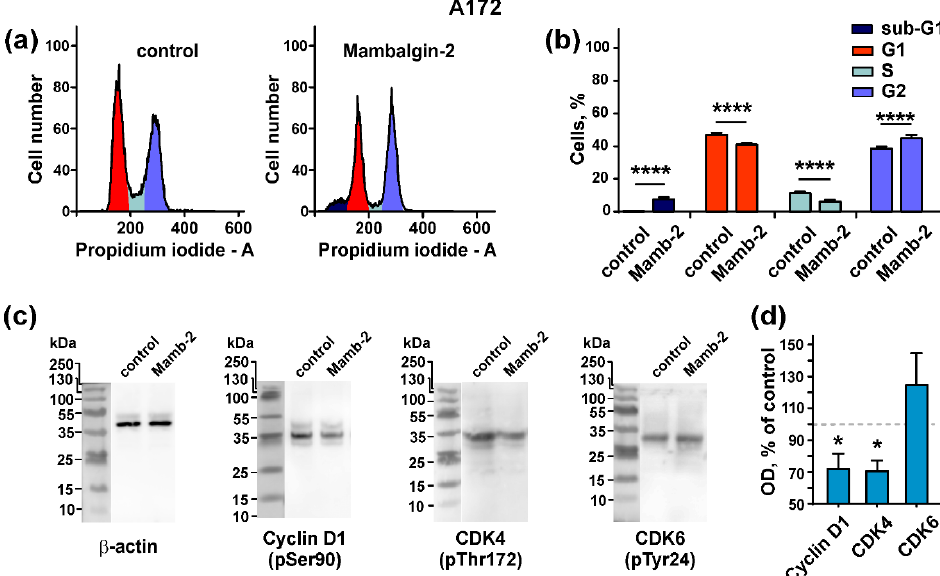
Figure 6. Mambalgin-2 influence on the cell cycle and activity of cell cycle regulators in A172 cells: ( a ) Representative nuclei population distributions of cells after 72-h incubation in absence (control) or presence of 1 µ M mambalgin-2; ( b ) % of cells in each cell cycle phase determined by ModFitLT Software. Data are presented as % of cells in each cell cycle phase ± SEM, n = 4; **** ( p < 0.0001) indicates the significant di ff erence from the control by two-tailed t -test; ( c ) Representative Western blots, showing the mambalgin-2 influence on phosphorylation of Cyclin D1 (pSer90), CDK4 (pThr172), and CDK6 (pTyr24); ( d ) The optical density (OD) of blot bands for comparison of the Cyclin D1 (pSer90), CDK4 (pThr172), CDK6 (pTyr24) expression upon 72-h incubation of the cells in absence (control) or presence of 1 µ M mambalgin-2. Data are presented as normalized to the β -actin band intensity, where untreated cells are taken as the control (100%, dashed line) ± SEM, n = 6; * ( p < 0.05) indicates the significant di ff erence between the control and mambalgin-2 treated cells by two-tailed t -test.